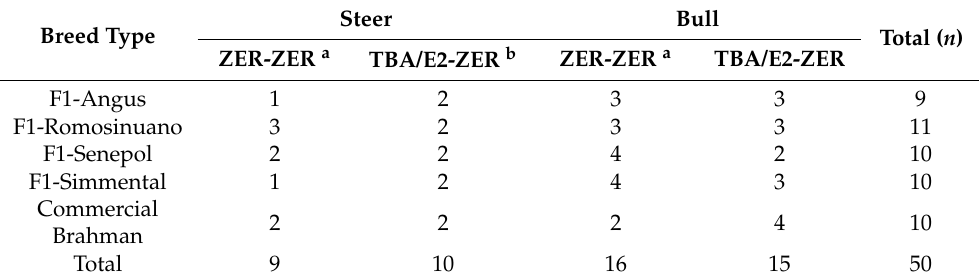
Table 1. Experimental design indicating the distribution of observations ( n ) by breed type, male class, and implant protocol (Experiment